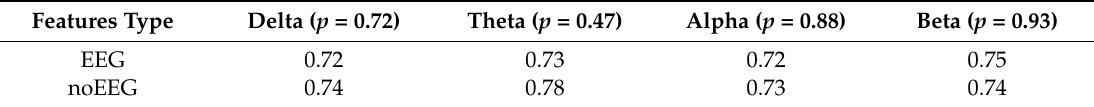
Table 3. Summary of statistical analysis on the discrimination accuracy. Specifically, for each EEG band and features type, the area under the curve (AUCs) and the p-value was reported. Features Type